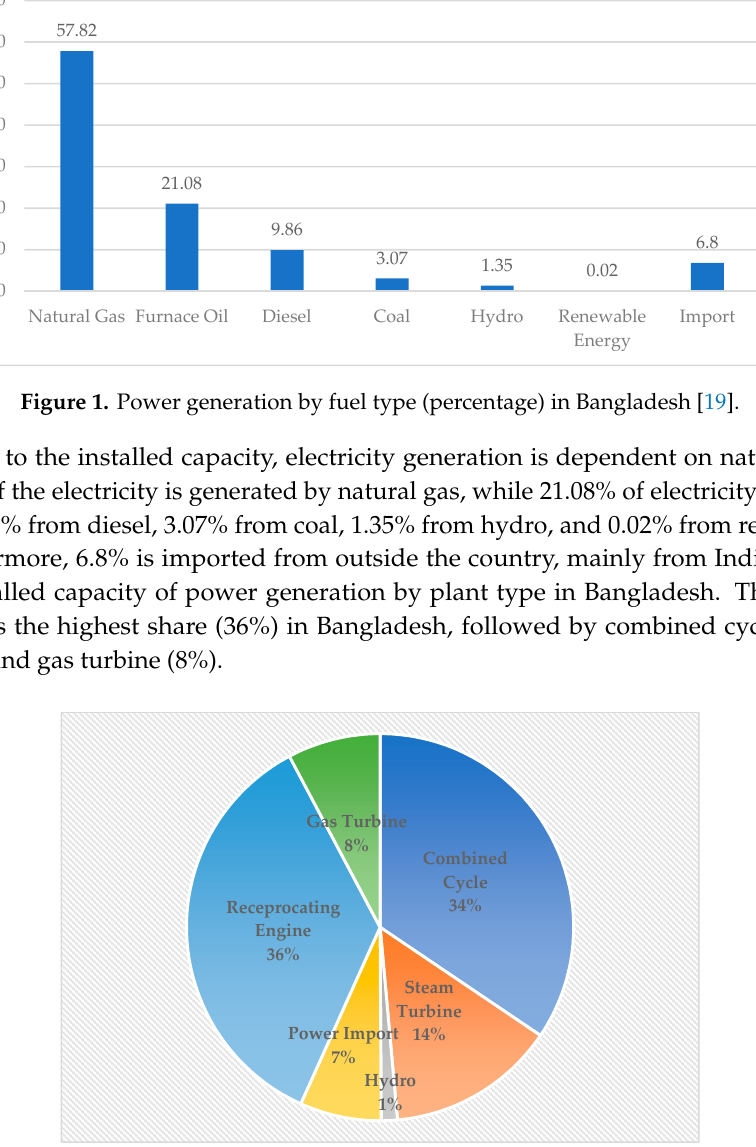
Figure 2. Installed capacity (17,043 MW) by plant type (percentage) [19].